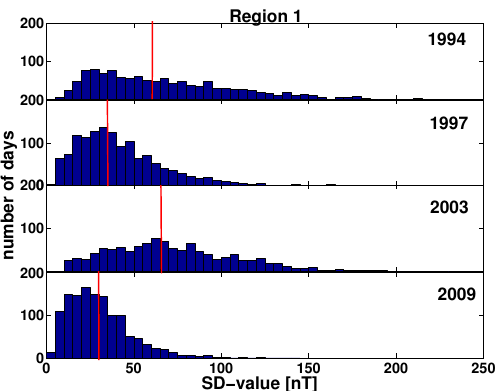
Figure 3. Yearly distributions of daily SD values of B X in Region 1 in 1994 and 2003 (active) and 1997 and 2009 (quiet). The red verti- cal lines show the median values of the distributions